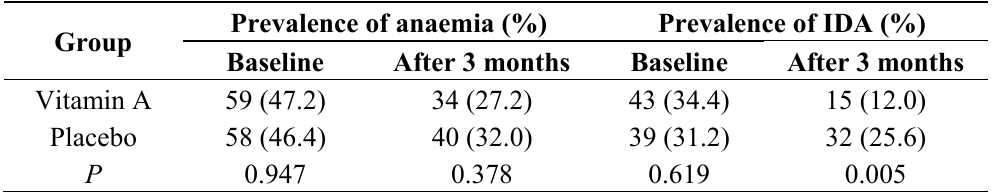
Table 4. Effects of vitamin A supplementation on prevalence of anaemia and IDA after 3 months.